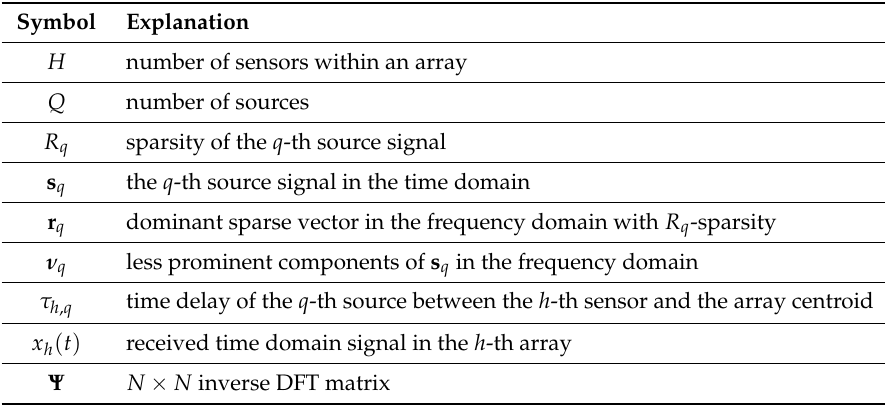
Table 1. Symbols and notations. CSJSR, compressive sensing joint sparse